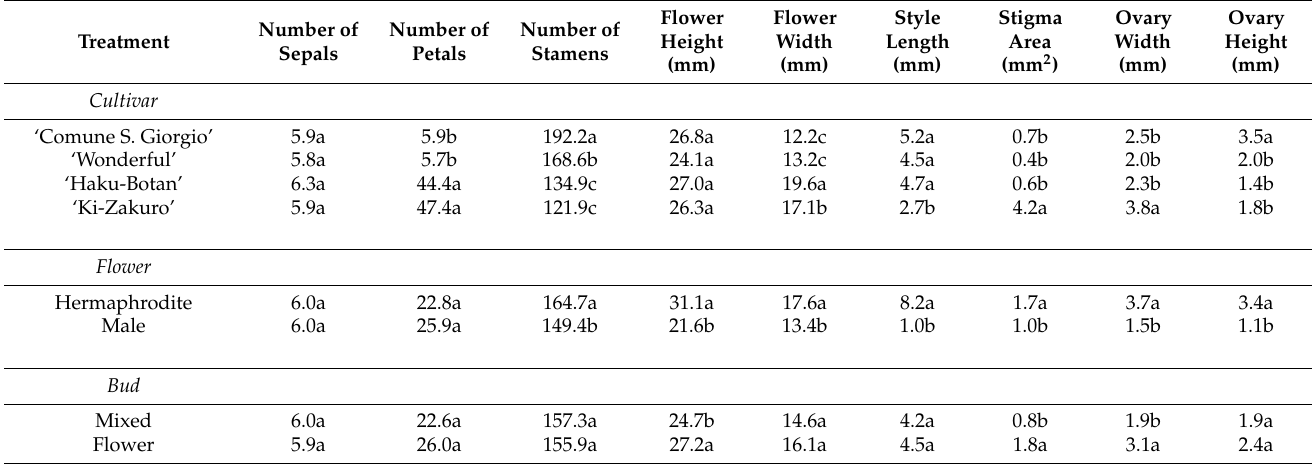
Table 2. Morphological parameters of the flowers of the different cultivars 1 .